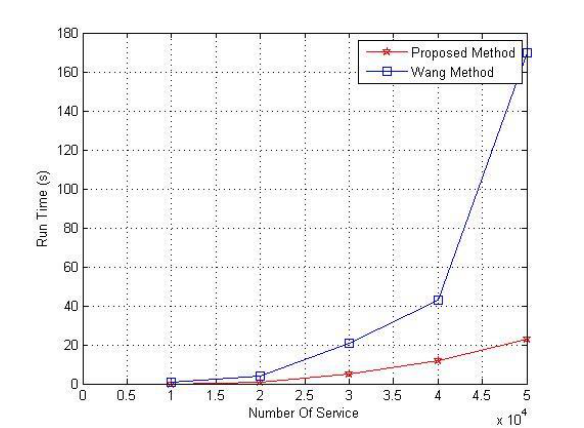
Figure 5. Comparison of runtimes per composition operations.